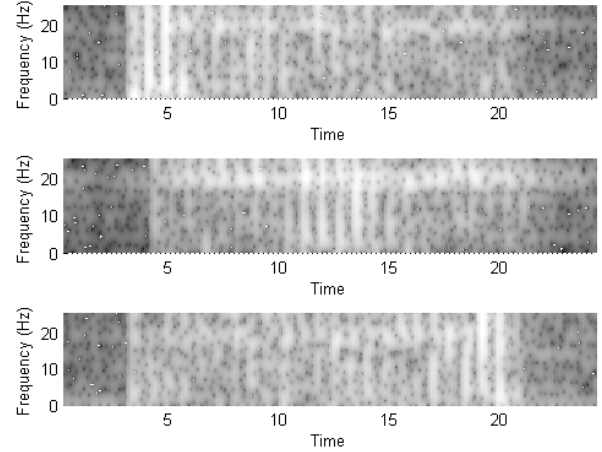
Fig. 17: Evolution of internal battery charge using 10W solar Fig. 19: Evolution of external battery charge using 50W solar